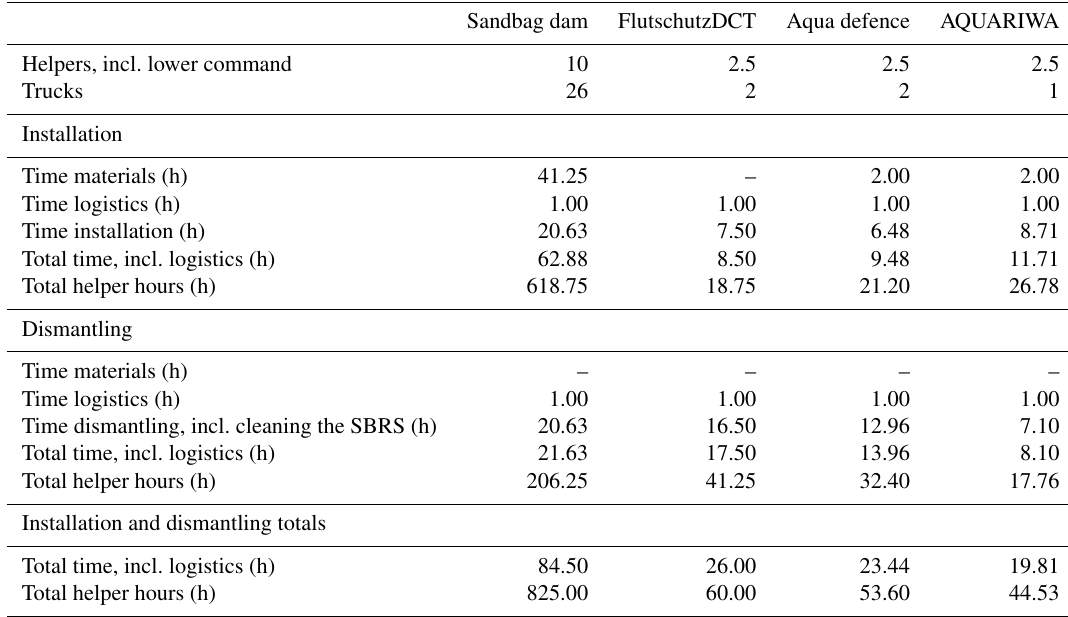
Table 7. Comparison of time, helpers and logistics requirements for the installation and dismantling of sandbag systems and SBRSs – temporary flood dam (case